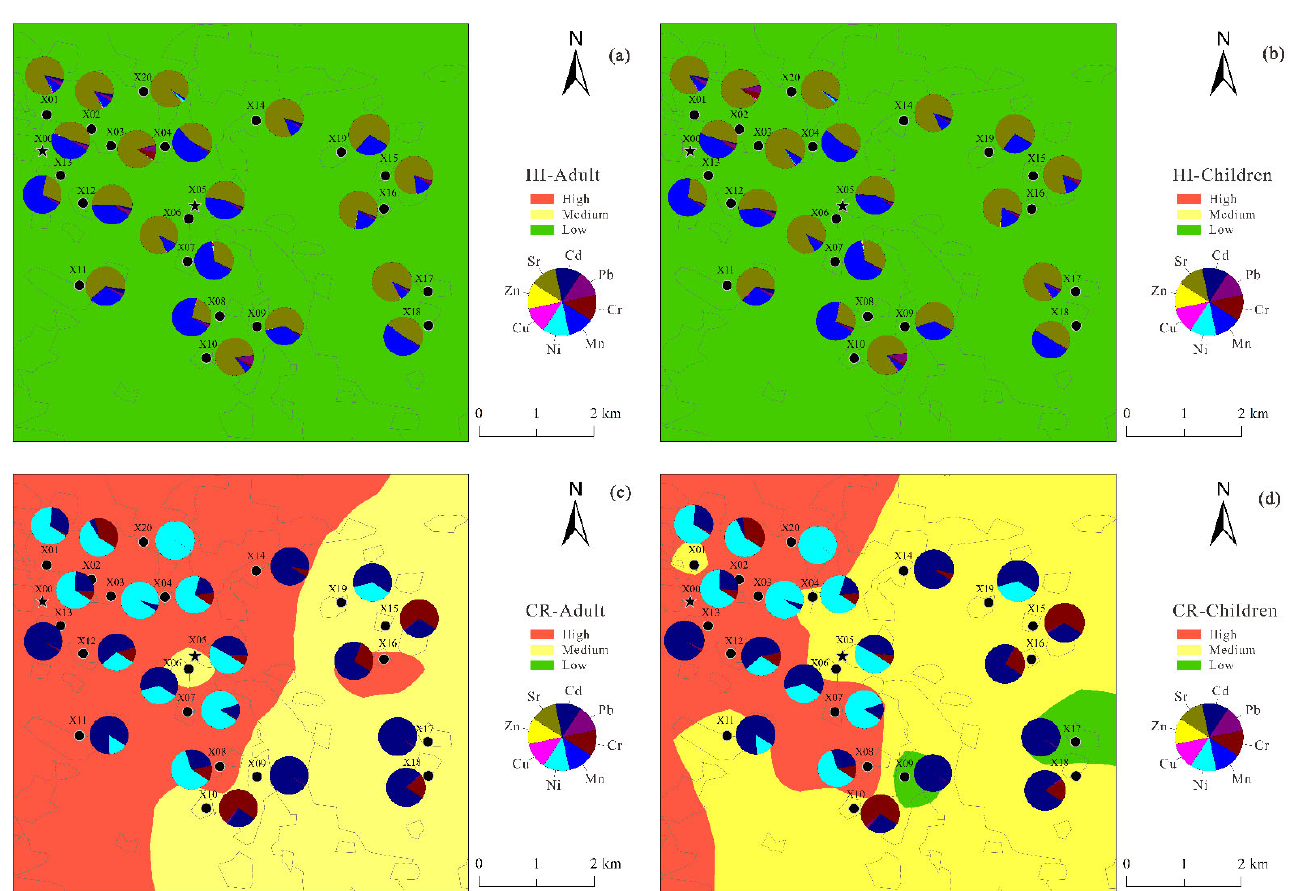
Figure 7. Spatial variation in HI and CR for ( a , c ) adults and ( b , d )